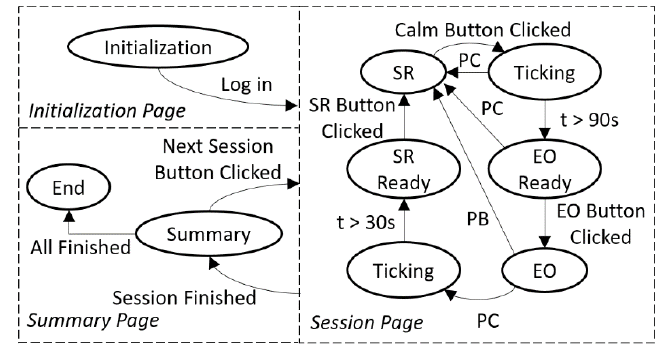
Figure 7. Finite state machine (FSM) of BDCI.